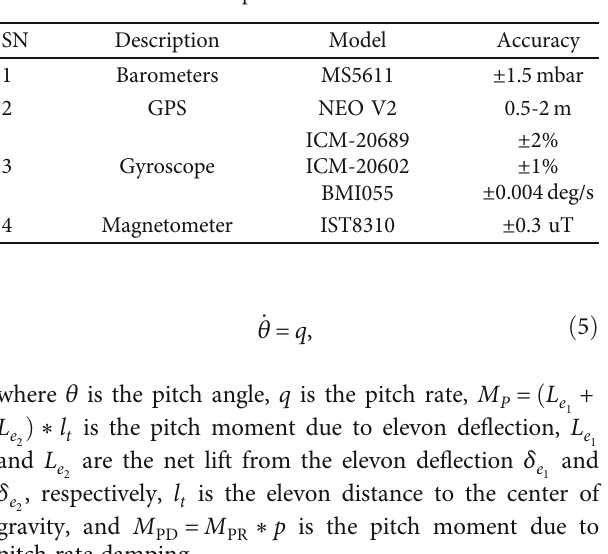
Table 4: The speci fi cations of the